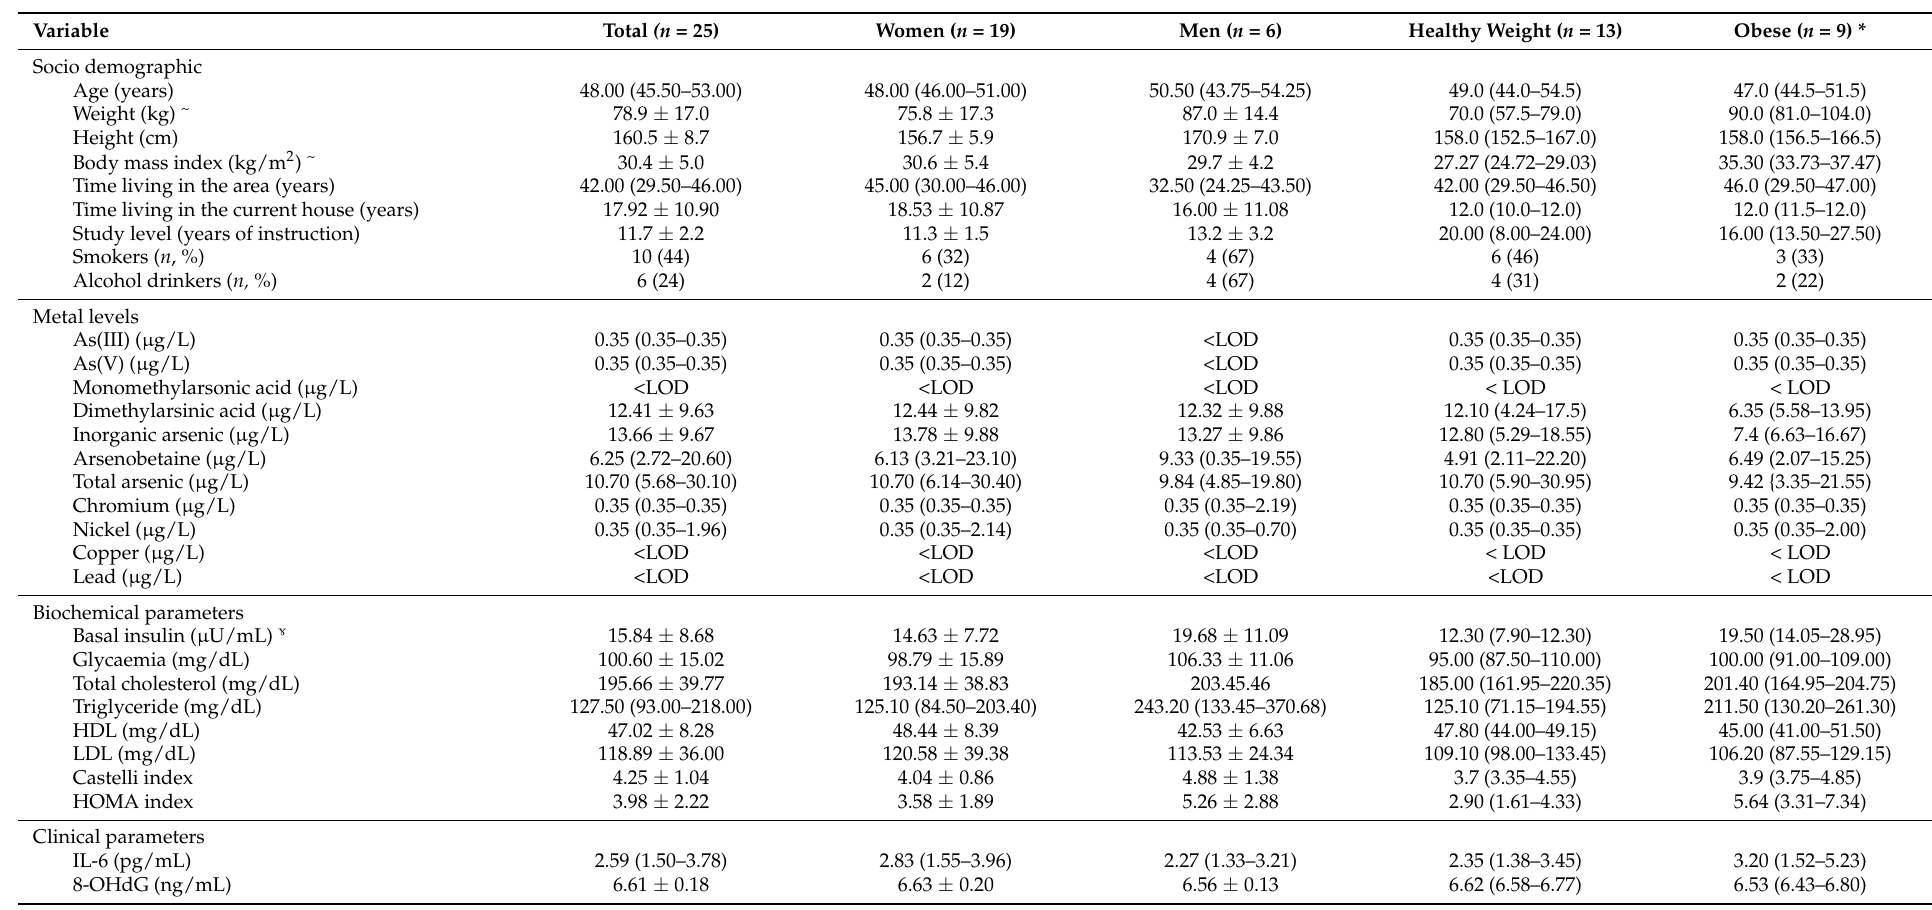
Table 1. Characteristics of the study sample, Chañaral, Chile. Statistical analysis between sex and between normal weight and obese